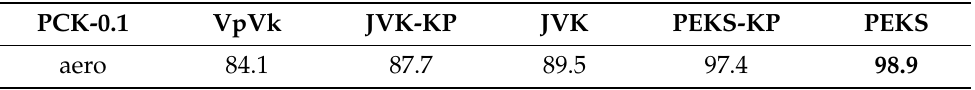
Table 5. Comparison with the state-of-the-art methods in terms of the Percentage of Correct Keypoints (PCK) metric on ObjectNet3D dataset. Bold number indicates the best results.